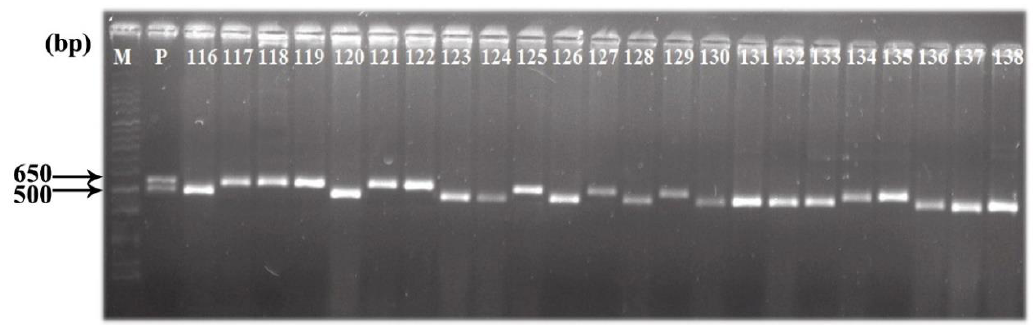
Figure 2. Identification of true DHs using STMS marker (RM23310). M: 100bp ladder taken